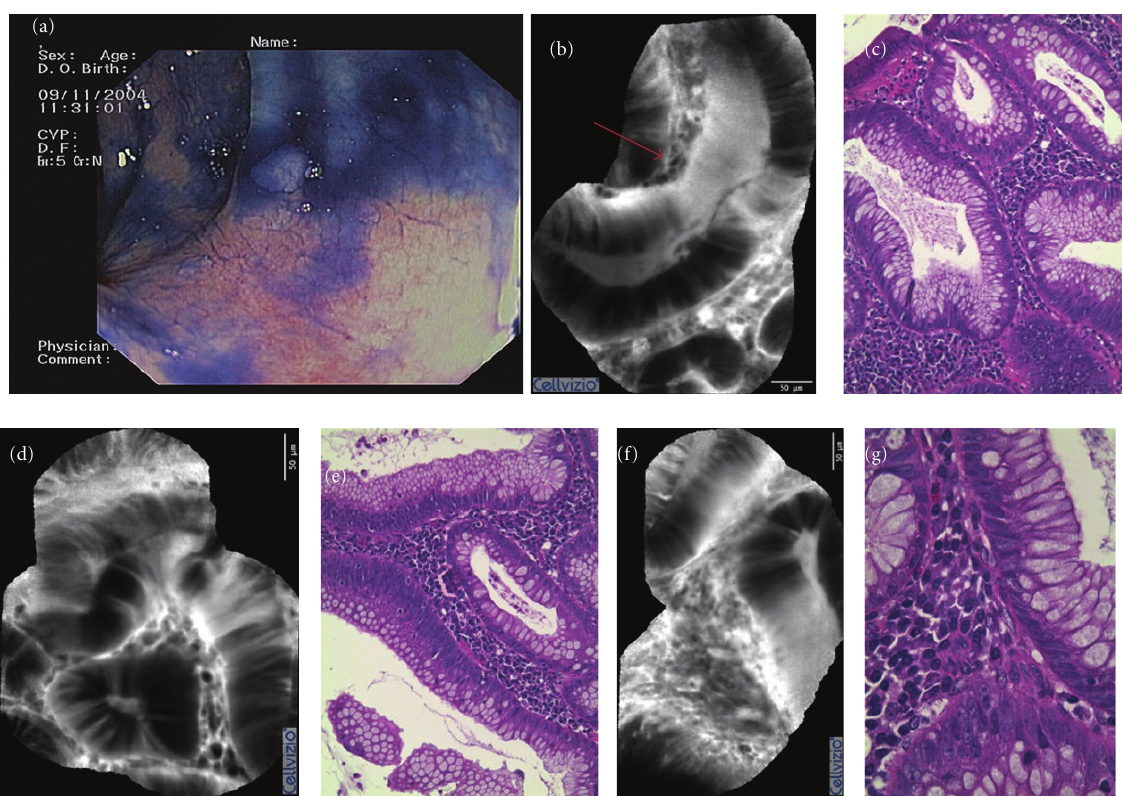
Figure 1: (a) Conventional “white-light” endoscopy of an ACF; (b), (d), and (f) pCLE of the lesion showing an enlarged crypt (red arrow, (b)) and normal globet cell density; (c), (e), and (g) hystologic features of the lesion, showing some enlarged crypts, with thickened epithelium with partial lack of stratification, in the presence of mild